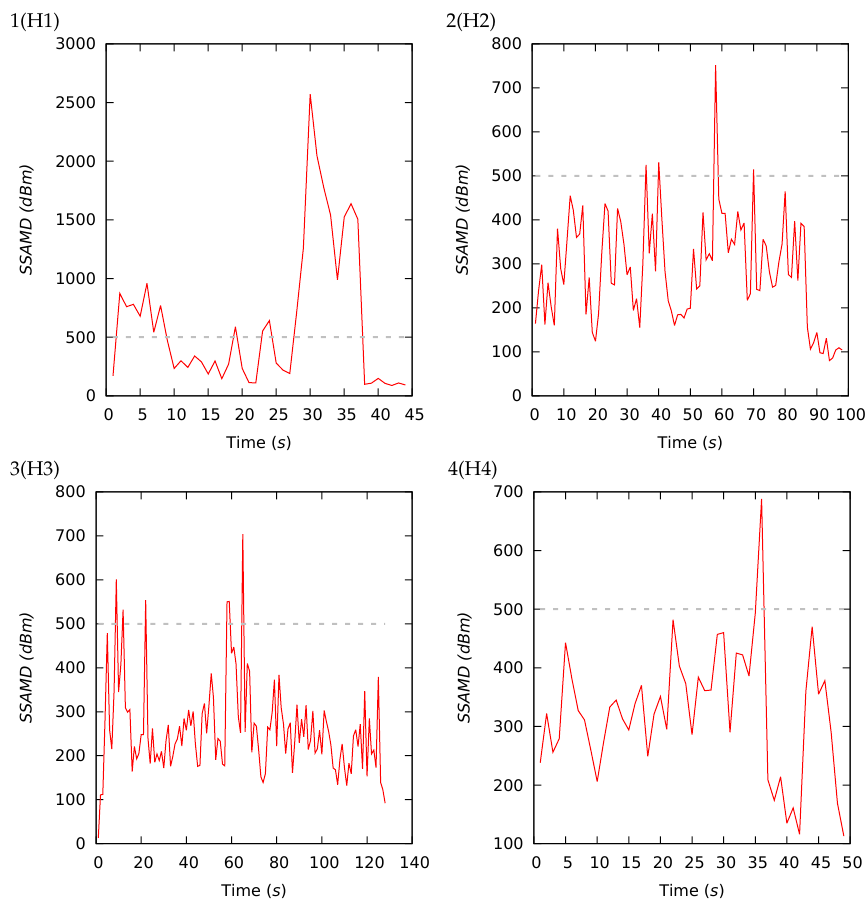
Figure 4. Experiment I. Phryganea grandis , various height